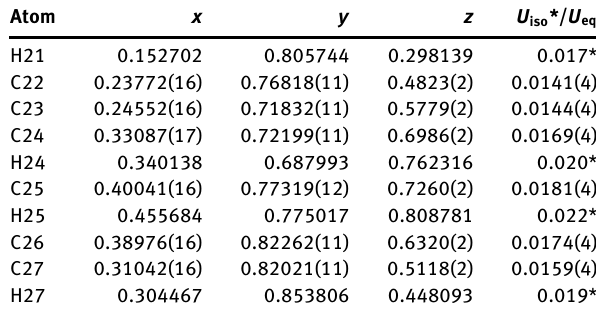
Table 2: Fractional atomic coordinates and isotropic or equivalent isotropic displacement parameters (Å 2